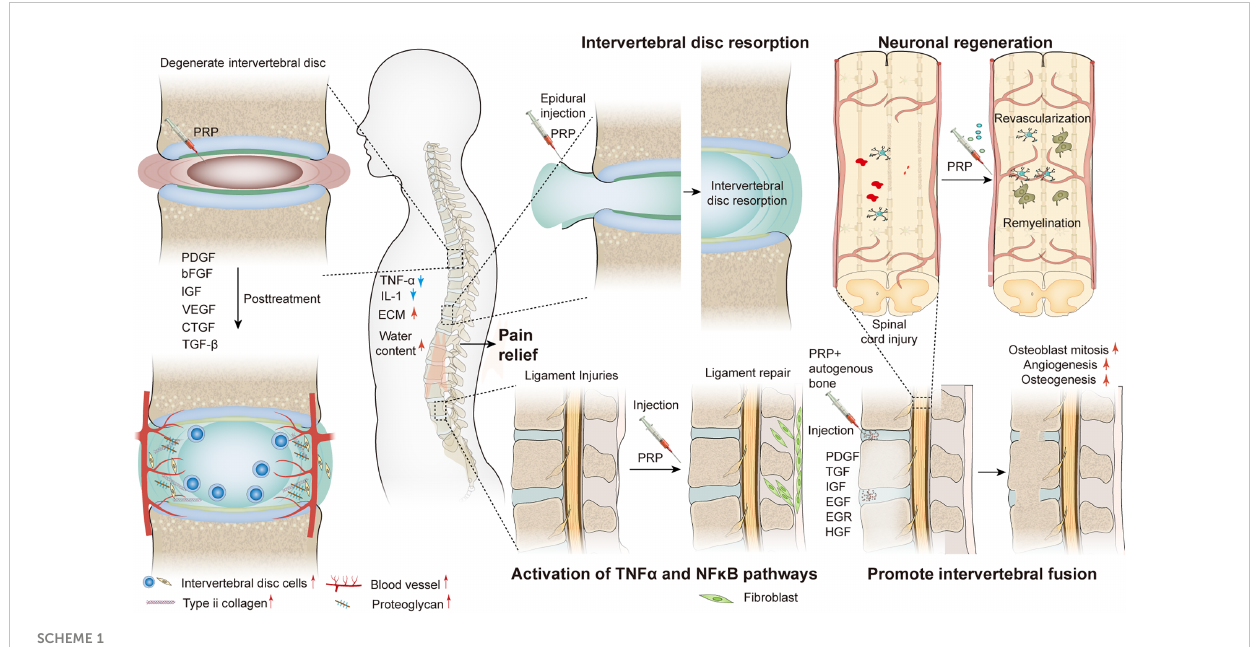
SCHEME 1 Schematic diagram of PRP in the treatment of spine-related